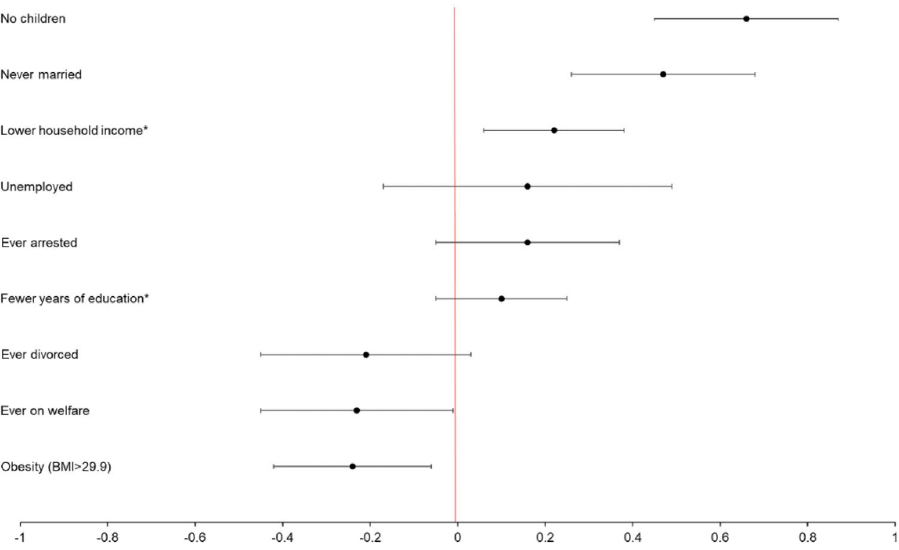
Figure 1. Estimated odds of functional outcomes by adolescent relative to adulthood-onset